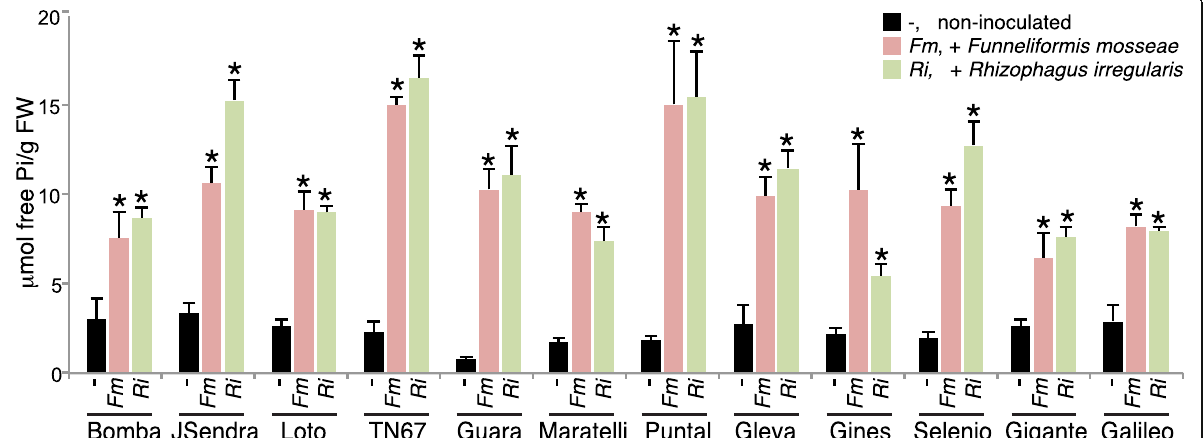
Fig. 2 Pi content in leaves of AM-inoculated rice varieties. The panel of temperate japonica rice cultivars was inoculated with AM fungi ( F. mosseae or R. irregularis ). Pi content was determined from leaf fragments collected from plants four weeks after inoculation with AMF (see Additional file 1: Figure S1a for the experimental design). Data are mean±SE ( n =5, each biological replicate is a pool of 2 individual leaves). Asterisks denote statistical differences (* p <0.05, ANOVA test; AMF-inoculated vs non-inoculated). Fm, Funneliformis mosseae; Ri, Rhizophagus